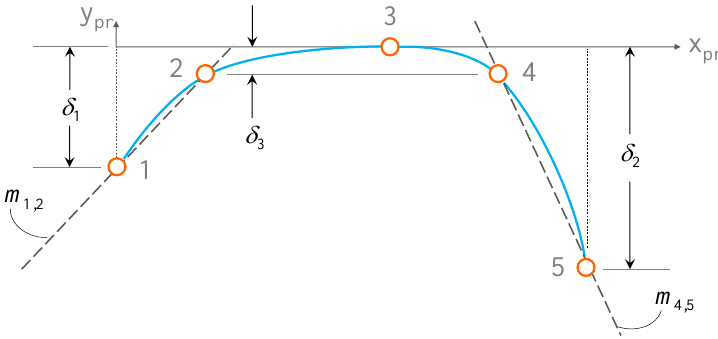
Figure 7. Form of profiles generated by Tailored Profile Generator Algorithm